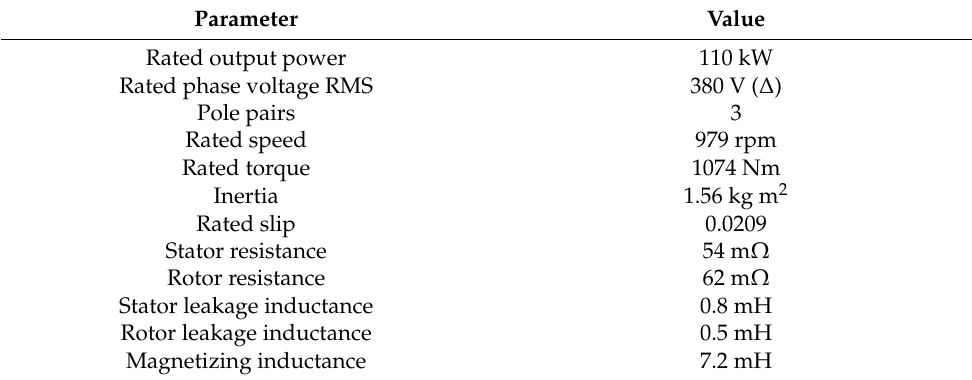
Figure 7. The simulated drive system with synchronous DTC scheme. Table 1. Motor Data.